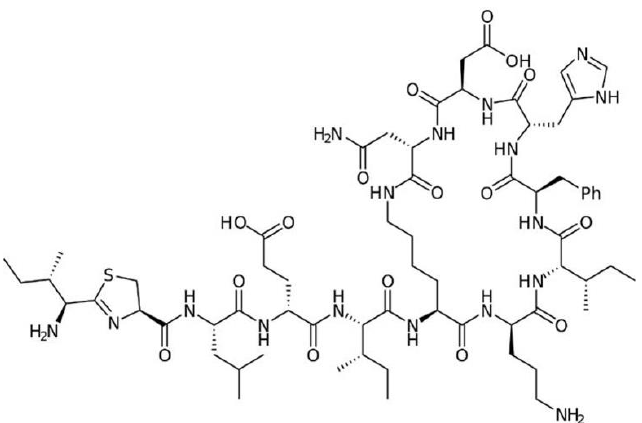
Figure 9. Structure of bacitracin.